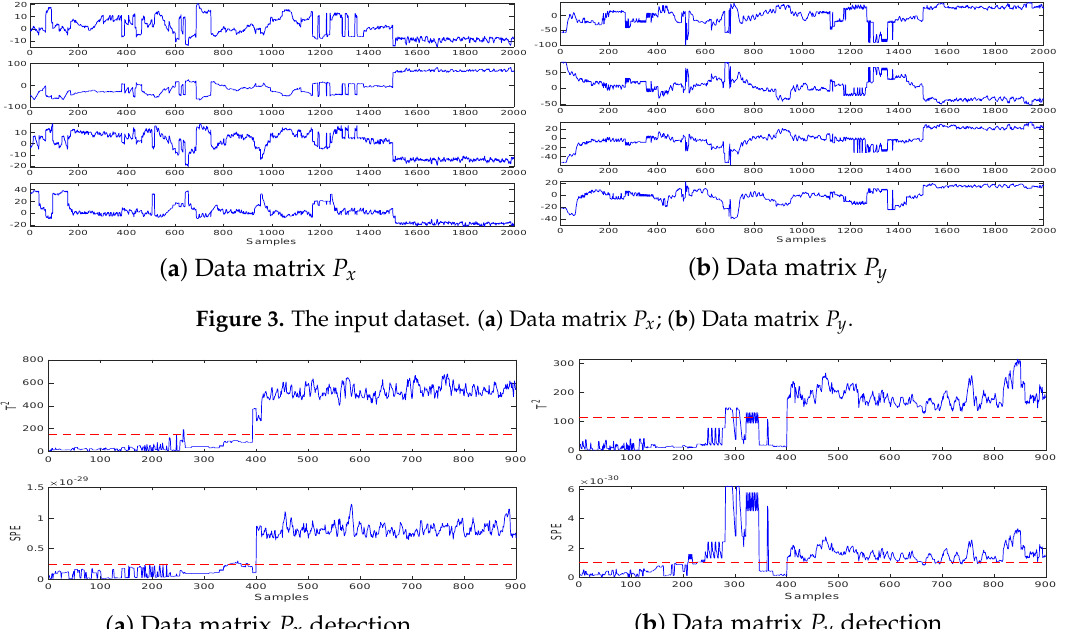
Figure 4. Experiment results of CCA-JITL FD model. ( a ) Data matrix P x detection; ( b ) Data matrix P y detection.